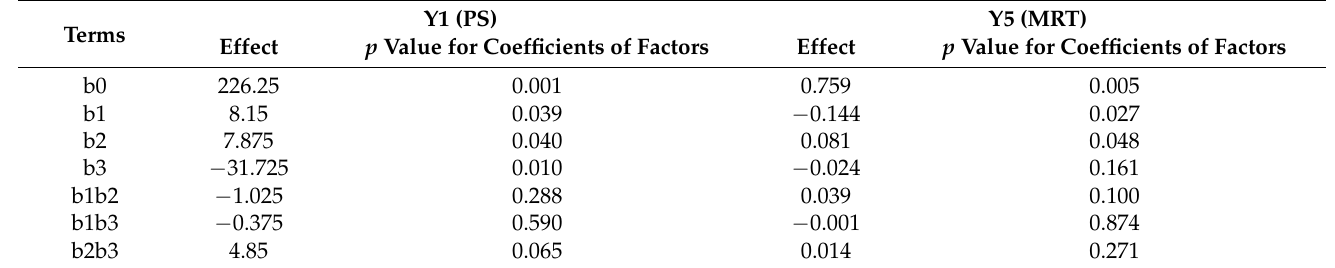
Table 2. Summary of results of the regression analysis of the significant models